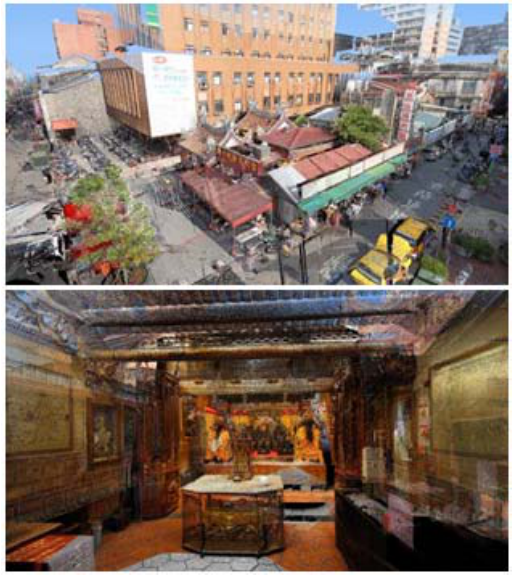
Figure 4. Digital data of 3D Laser Scanning